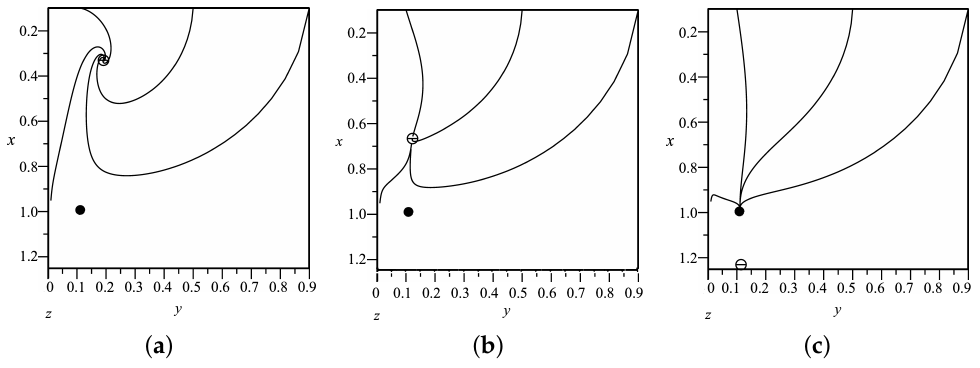
= 3 for EC(green) and LQC(black). k 2